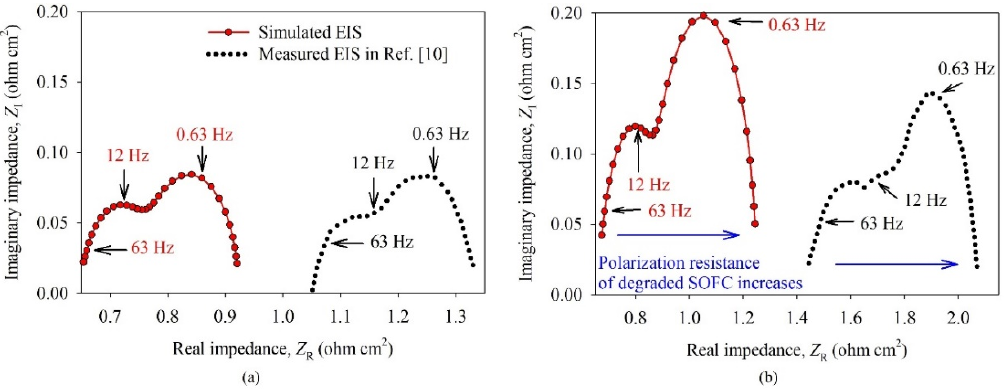
Figure 6. Electro-impedance spectrum (EIS) of ( a ) non-degraded SOFC (at time t = 0 h) and ( b ) degraded SOFC (at time t = 1000 h). Three different frequencies ( f = 0.63, 12, and 63 Hz) are labeled for